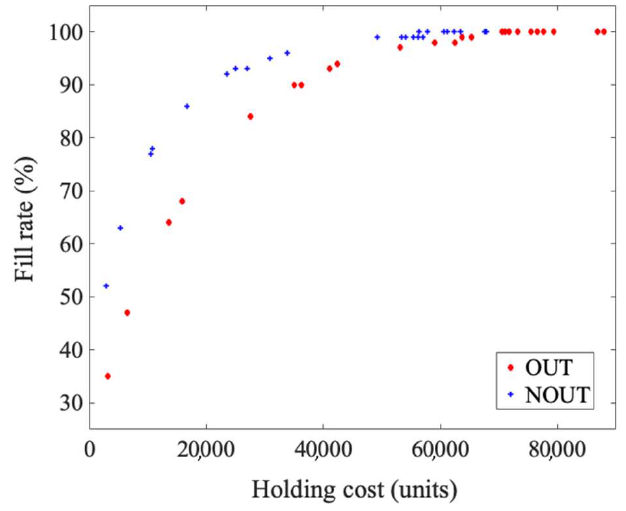
Figure 11. Fill rate vs. holding costs trade-off for network N2.